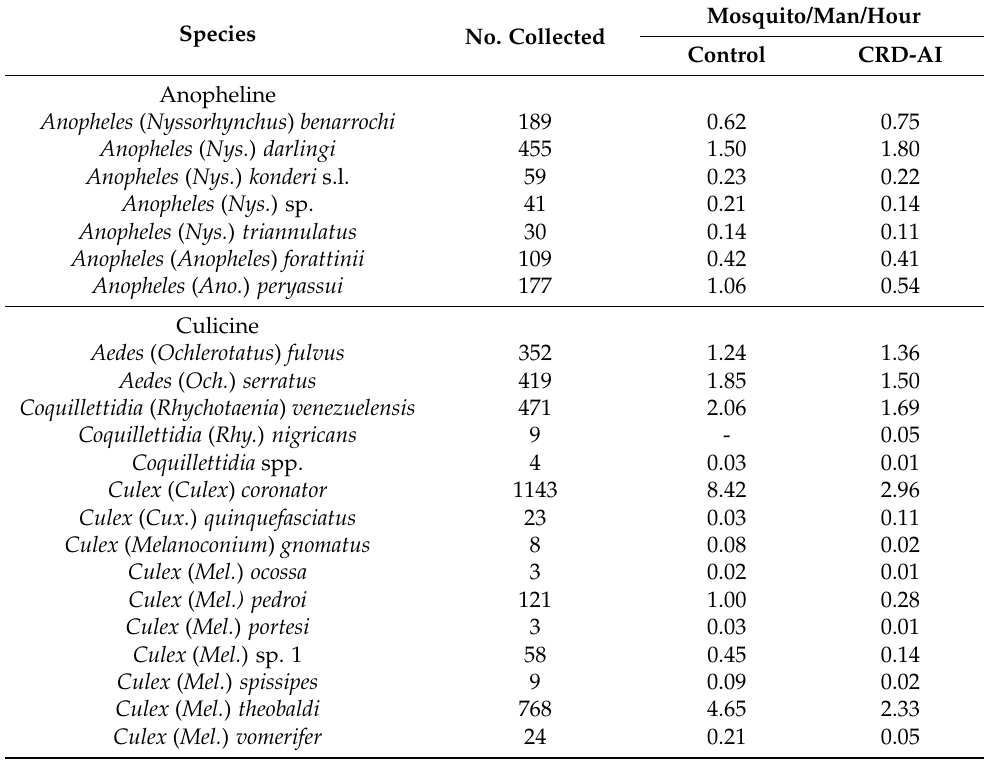
Table 1. Mosquito species recorded during protected human landing collections in Mapacocha, Loreto, Peru, between 10 and 26 January 2017, evaluating novel spatial repellent devices with metofluthrin. Total number of mosquitoes collected and hourly mosquito catches by species are shown near CRDs with no metofluthrin (Control) and CRDs that released metofluthrin (CRD-AI). Mosquito/Man/Hour Species No. Collected Control CRD-AI